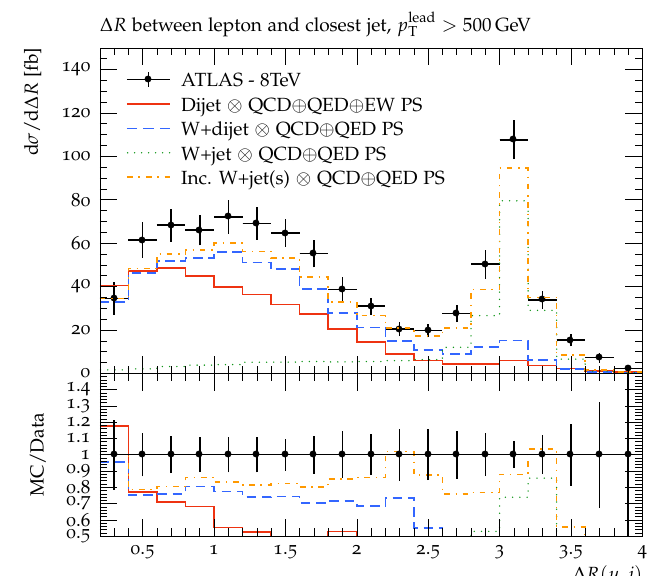
Figure 13. The angular distribution of W ± bosons accompanied with high transverse momentum √ jets at s = 8 TeV. The data is from ATLAS [32], showing the angular distribution of the muon and the closest jet with p t > 500 GeV. The blue dashed and green dotted histograms are produced using W ± + jet and W ± + 2 jets MEs, respectively, while the orange dash-dotted histogram represents their sum. The corresponding MEs have been generated via MadGraph and showered in Herwig with its QCD + QED scheme. On the other hand, the red solid histogram is calculated by showering a pure QCD dijet event with Herwig ’s new QCD + QED + EW scheme.